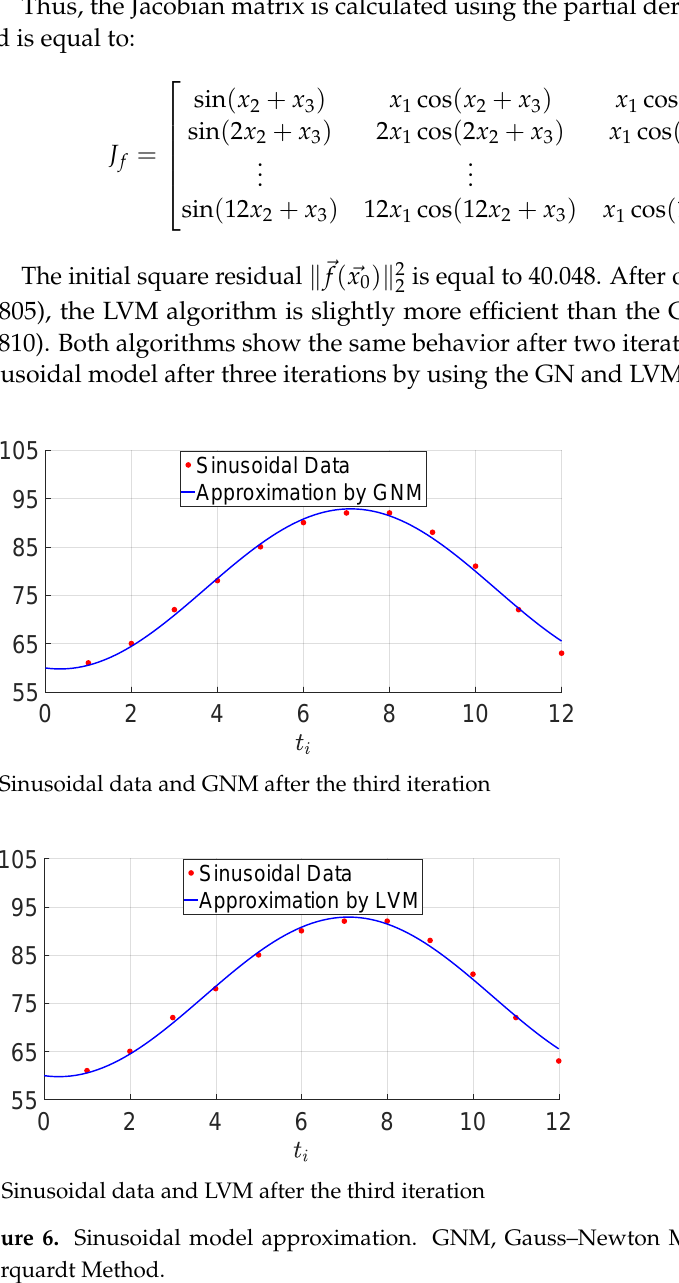
Figure 6. Sinusoidal model approximation. GNM, Gauss–Newton Method. LVM, Levenberg– Marquardt Method.